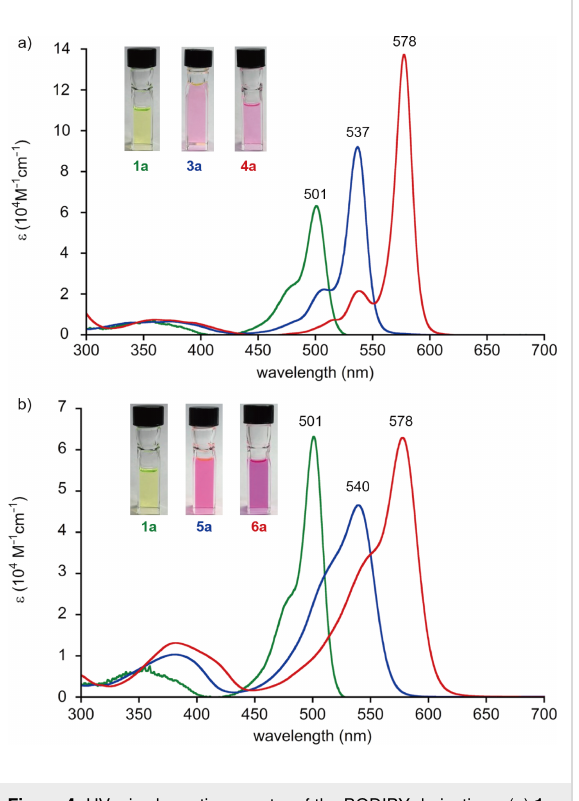
ly, the relatively broad emission bands were observed with lowered quantum yields, Φ f of 0.25 and 0.16, respectively (Figure 5b and Table 1). The larger Stokes shift and shorter emission lifetime suggest a rapid decay of the excited species after structural relaxation (vide infra, Table 1). Also, inter- system crossing to the triplet state can be another pathway to